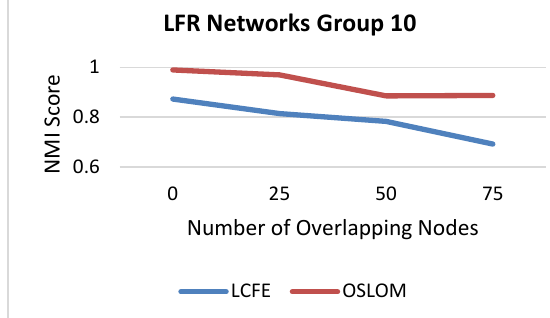
Fig. 12. NMI score comparison for LCFE and OSLOM for tenth group of LFR Networks with number of overlapping nodes ranging from 0 to 75